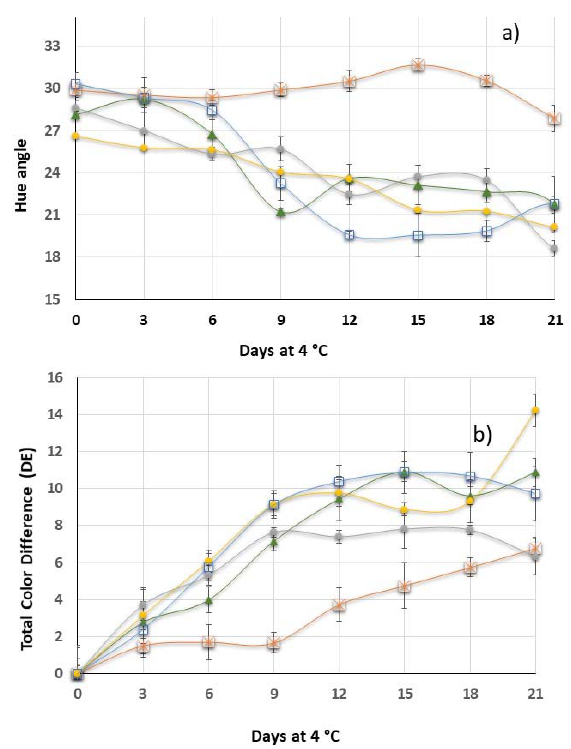
Figure 2. Changes in color parameters of strawberries at 4 °C: ( a ) changes in hue angle; ( b ) Total color difference ( Δ E). Control, XG, 10BSLN, 20BSLN, 30BSLN. Error bars represent the standard deviation of the triplicate results.